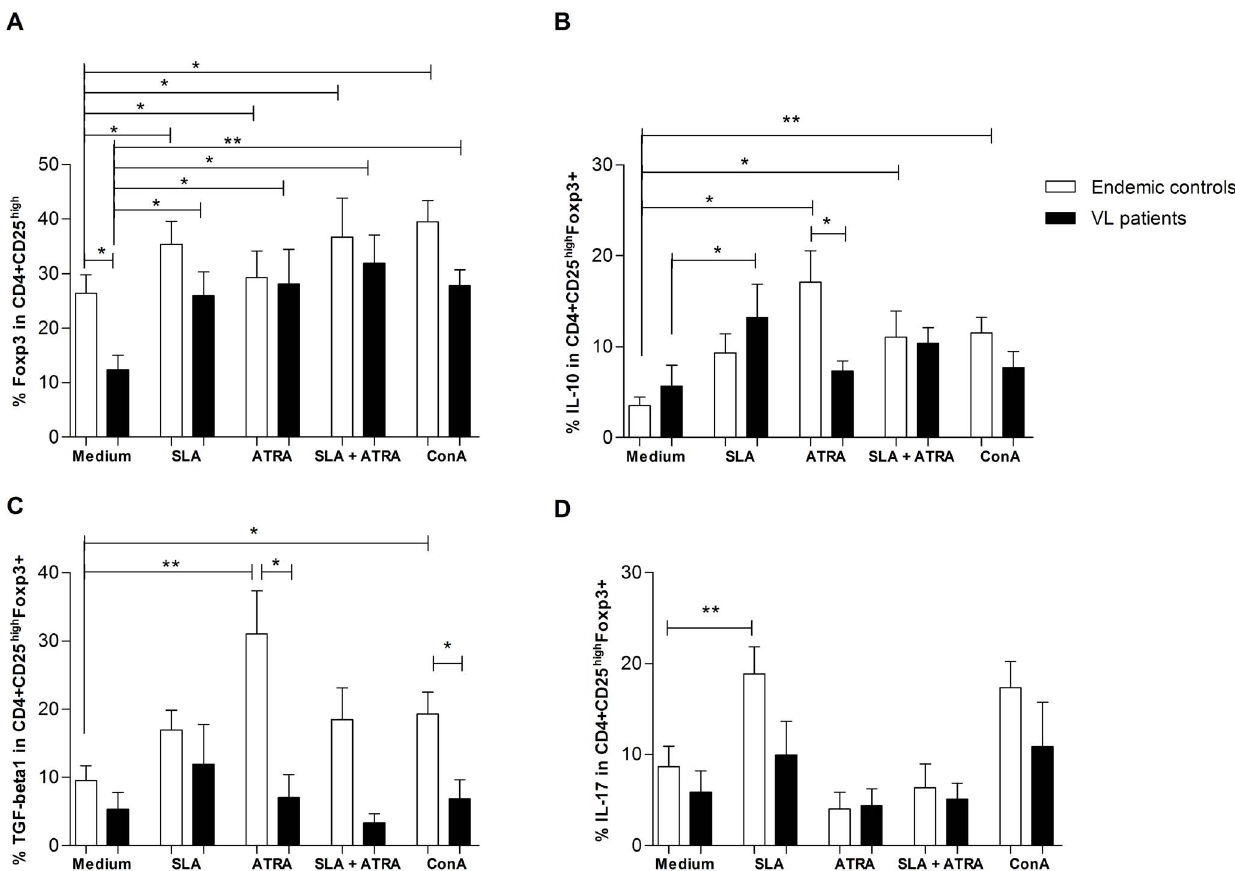
Figure 3. Cytokines expression in CD4 + CD25 high Foxp3 + T cells in response to different stimuli. A . Lower frequency of CD4 + CD25 high Foxp3 + T cells in VL patients when compared to endemic controls and its increase after all stimuli. B . IL-10 production in CD4 + CD25 high Foxp3 + T cells after tested conditions. C . TGF- b 1 production in CD4 + CD25 high Foxp3 + T cells after tested conditions. D . IL-17 in CD4 + CD25 high Foxp3 + T cells after tested conditions. Mann-Whitney test was used to compare endemic controls to VL patients. Wilcoxon matched pairs test was used to compare cultures stimulated and non-stimulated within the studied groups. * p , 0.05; ** p , 0.01. Subjects tested: endemic controls (n=16) and VL patients (n=10). Bars represent median and IQR. ATRA = all-trans retinoic acid. SLA = Soluble Leishmania antigens (SLA). ConA = Concanavalin A.